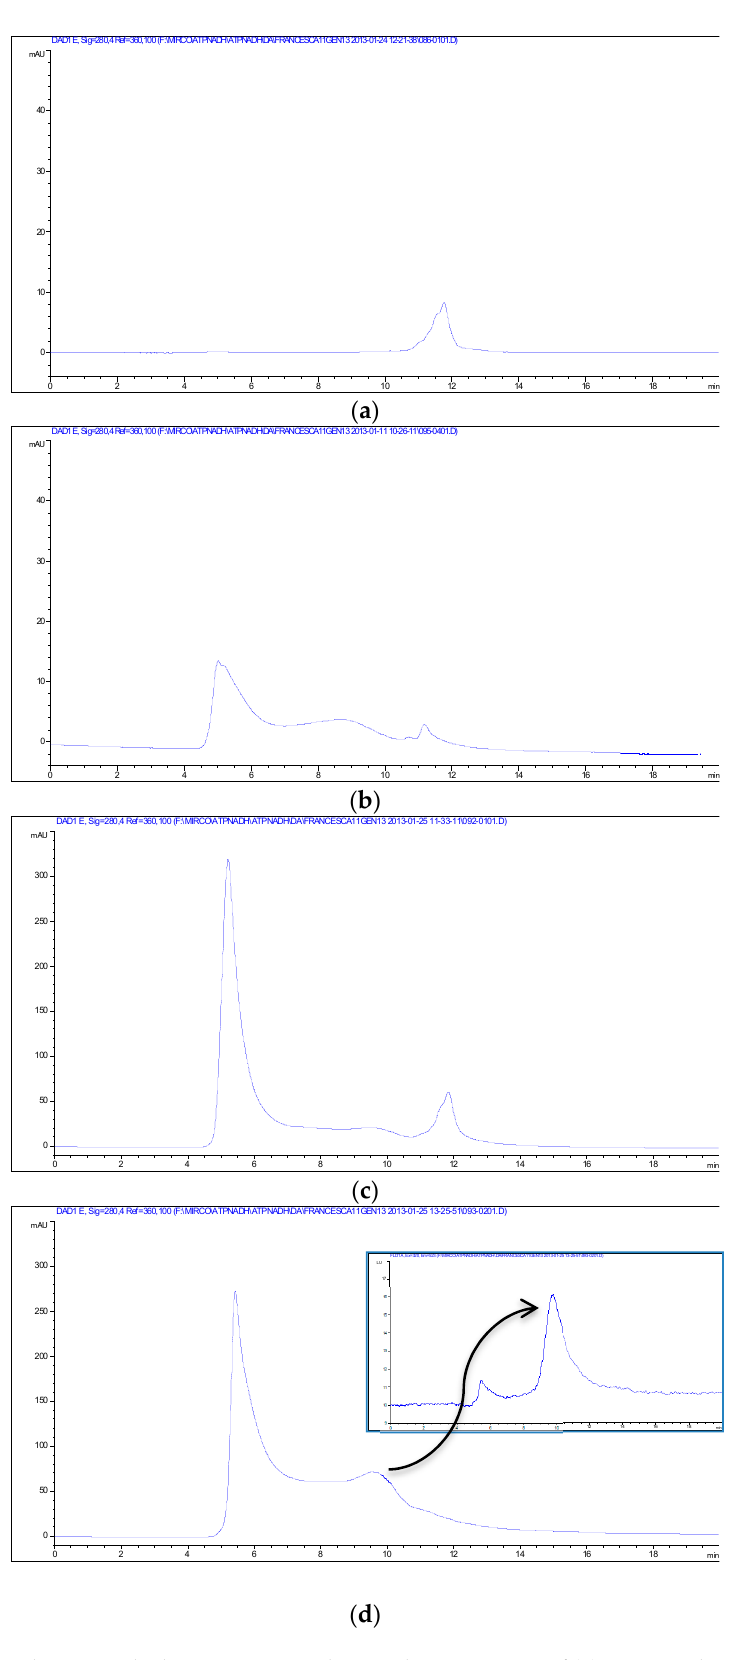
Figure 6. From the top to the bottom: Size-exclusion chromatogram of ( a ) TADH solution; ( b ) TADH solution incubated with NPs (100 μ L TADH solution: 5 μ L Pd NPs solution); ( c ) TADH solution incubated with NPs (100 μ L TADH solution: 15 μ L Pd NPs solution); ( d ) TADH solution incubated with NPs (100 μ L TADH solution: 25 μ L Pd NPs solution) with its fluorescence data (inset).